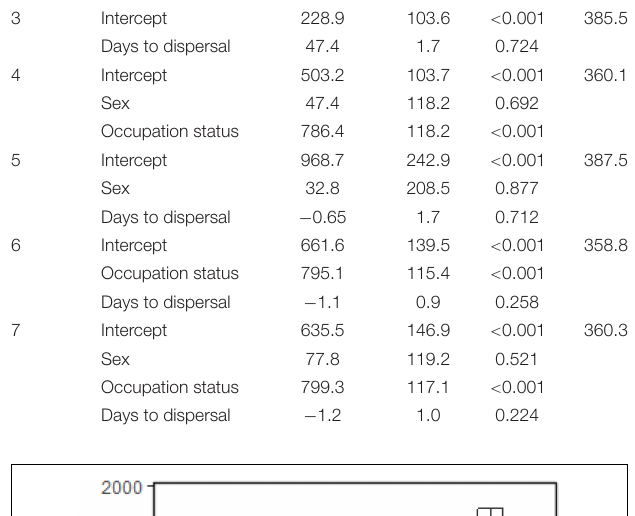
FIGURE 5 | Geographical distribution of territories identified by the AFTS algorithm as newly settled by satellite tagged birds, according to the prior occupation status of the territory (V = vacant, O = occupied). The inset shows the location of Scotland in western Europe.